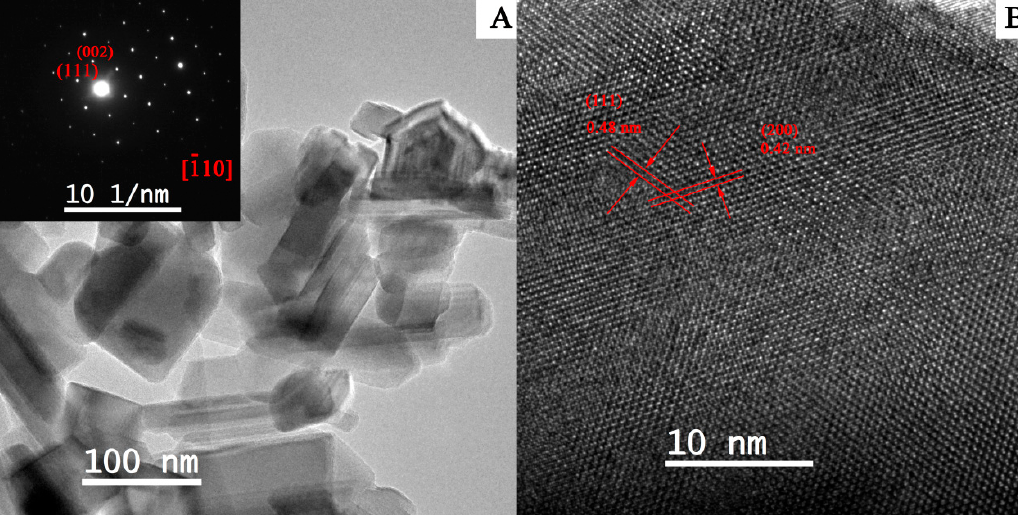
Figure 3. TEM image ( A ) and high resolution (HR)TEM image ( B ) of Ce-doped LTO [inset of A, the corresponding selected area electronic diffraction (SAED) pattern].